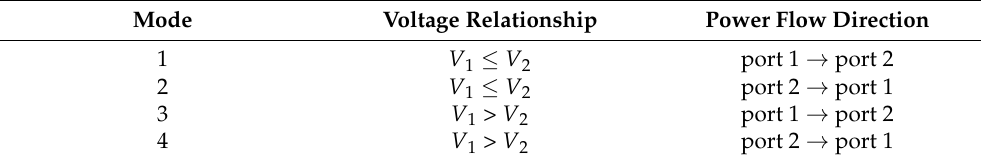
Table 1. Operating modes of the Split-pi